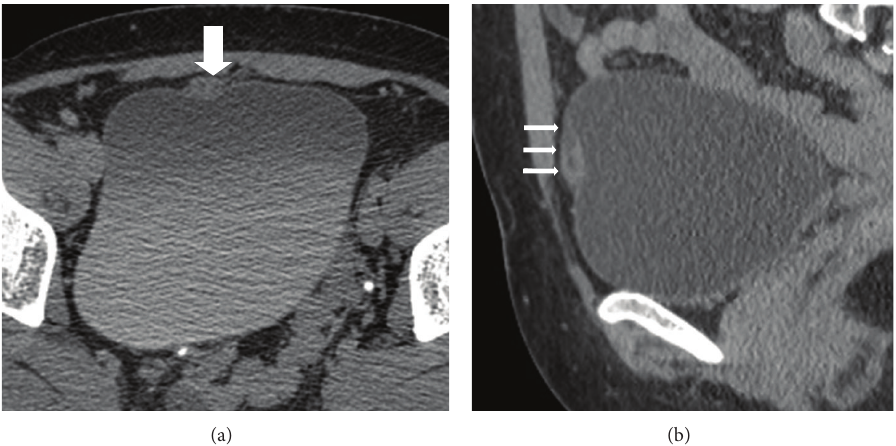
Figure1:Contrast-enhancedCTrevealedafusiformmasswiththickwall((a),largewhitearrowonaxialCTimaging)andinternalmillimetric cystic components overlying the anterosuperior portion of bladder ((b), small white arrows on sagittal CT imaging).